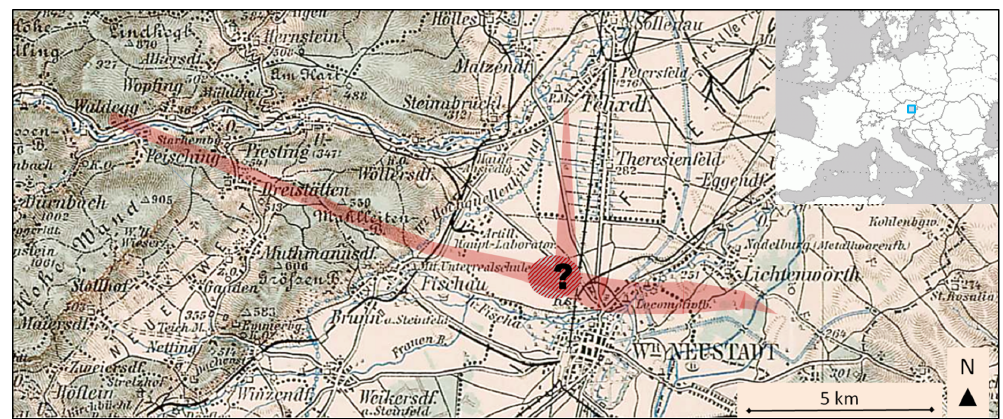
Figure 2. Map of tornado damage tracks (red shadings) in the Wiener Neustadt area. The hatched area with the question mark denotes the airfield west of town, where the exact genesis of the main tornado is unknown. The map used as a based was the “Generalkarte von Mitteleuropa des k.u.k. Militärgeographischen Instituts Wien, Blatt 34 ◦ 48 ◦ Wien” of